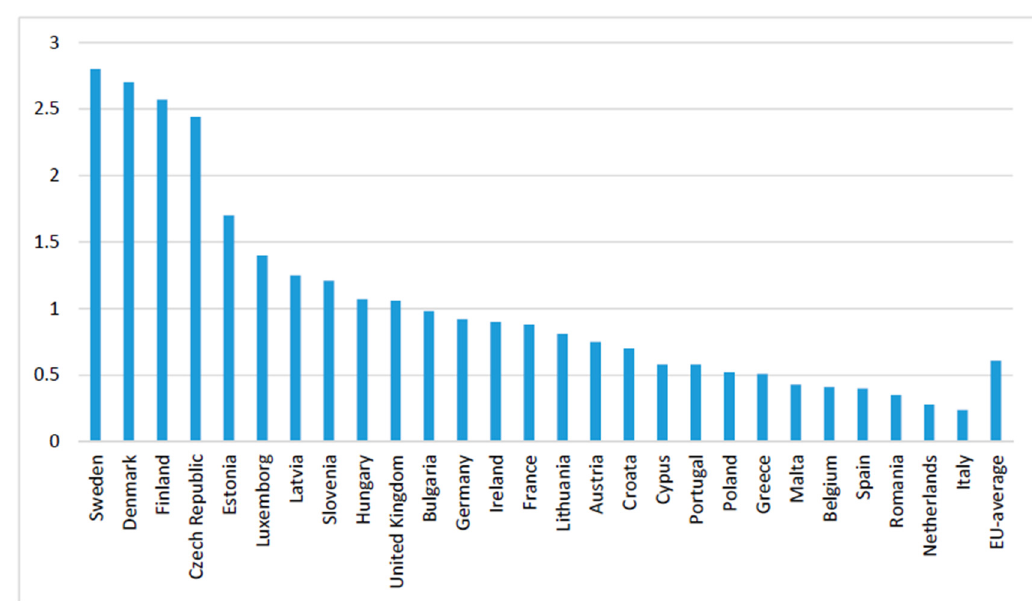
Figure 2. The share of the balance of subsidies and taxes from investment and operating activities in 2004. (for Bulgaria and Romania, the years considered are 2007–2017, for Croatia the years 2013–2017 and due to the loss generated by family farming on average in Slovakia in the period 2004–2017, this country is not included in Figure 2). Source: own elaboration based on FADN data.